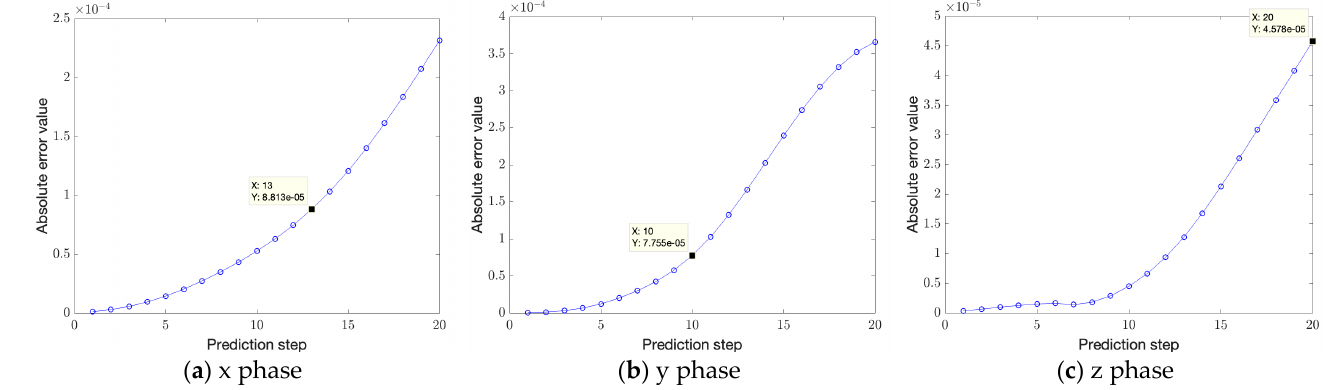
absolute error value curve, and the blue circle represents the absolute error value.